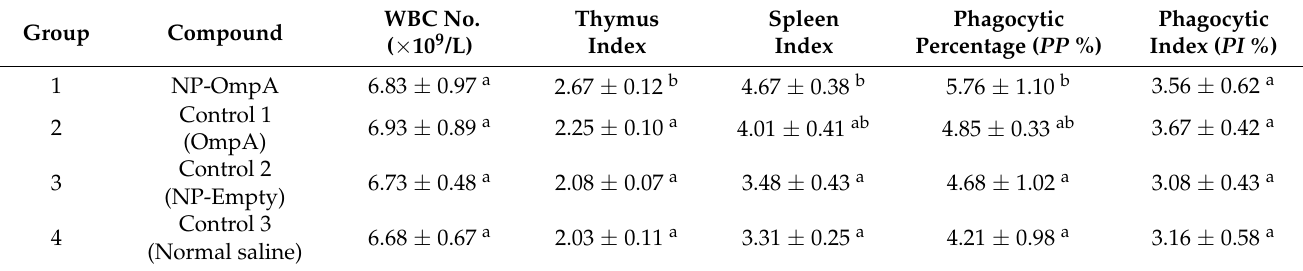
Table 2. WBC, organ index, and leukocyte phagocytosis of S. aureus values.